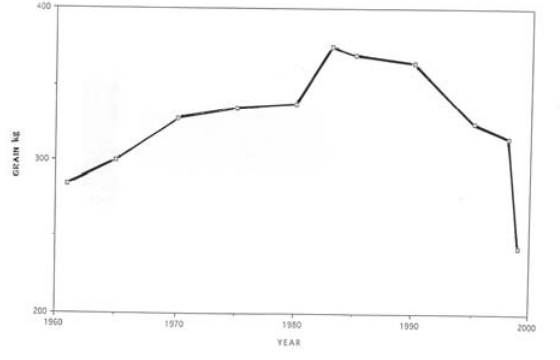
Figure 1. World per capita grain production from 1960 to 2000